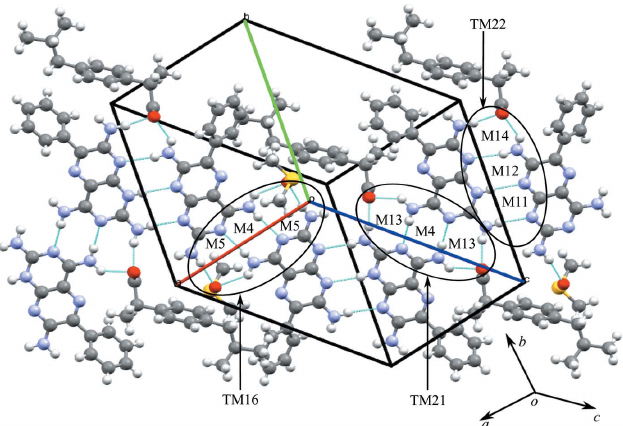
Figure 15 The crinkled tape of molecules of 1 with molecules of coformer g and solvent DMSO with the motifs M5, M4 and M5 (TM16), M13, M4 and M13 (TM21), M11, M12 and M14 (TM22), and M11 and M12 (TM23) in the crystal structure of 1g (cid:3) DMSO.